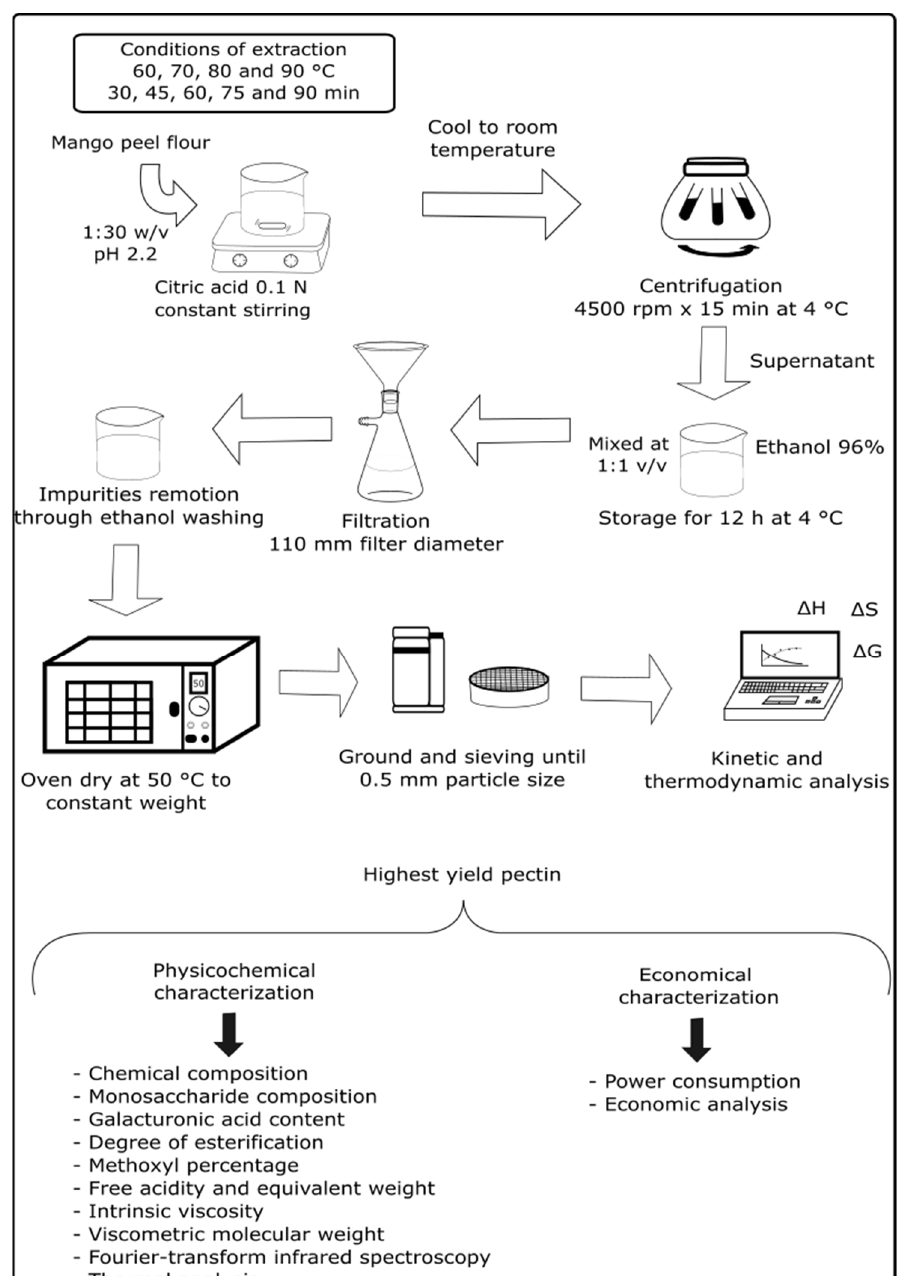
Figure 1 . Extraction strategy of Haden mango peel pectin and further analyses of the highest yield